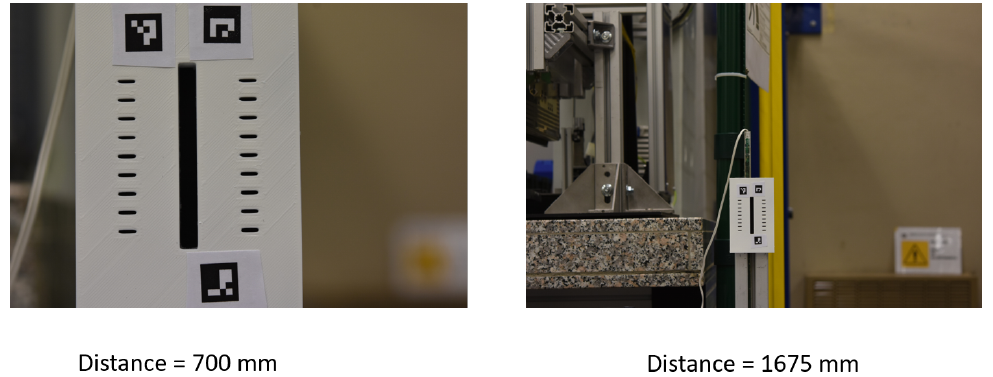
Figure 28. Acquisition setup. On the left, a picture framed at a distance of 700 mm. On the right a picture framed at a distance of 1675 mm.